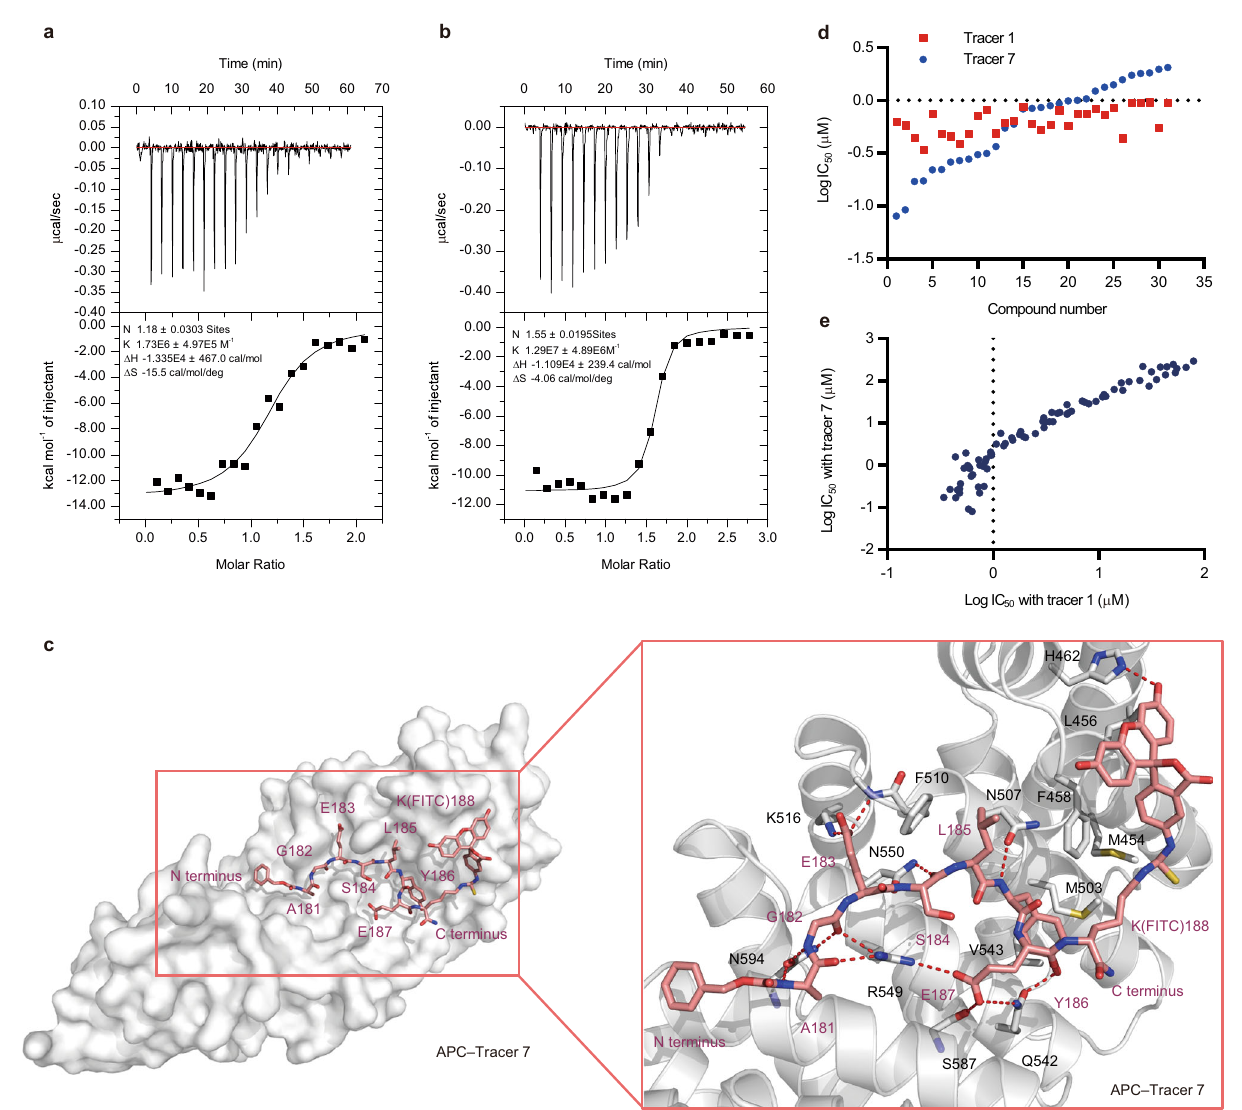
carbonatoms).Thereddashedlinesrepresentthehydrogenbondsbetweentracer 7 (pink carbon atoms) and APC (gray carbon atoms). d Log-transformed